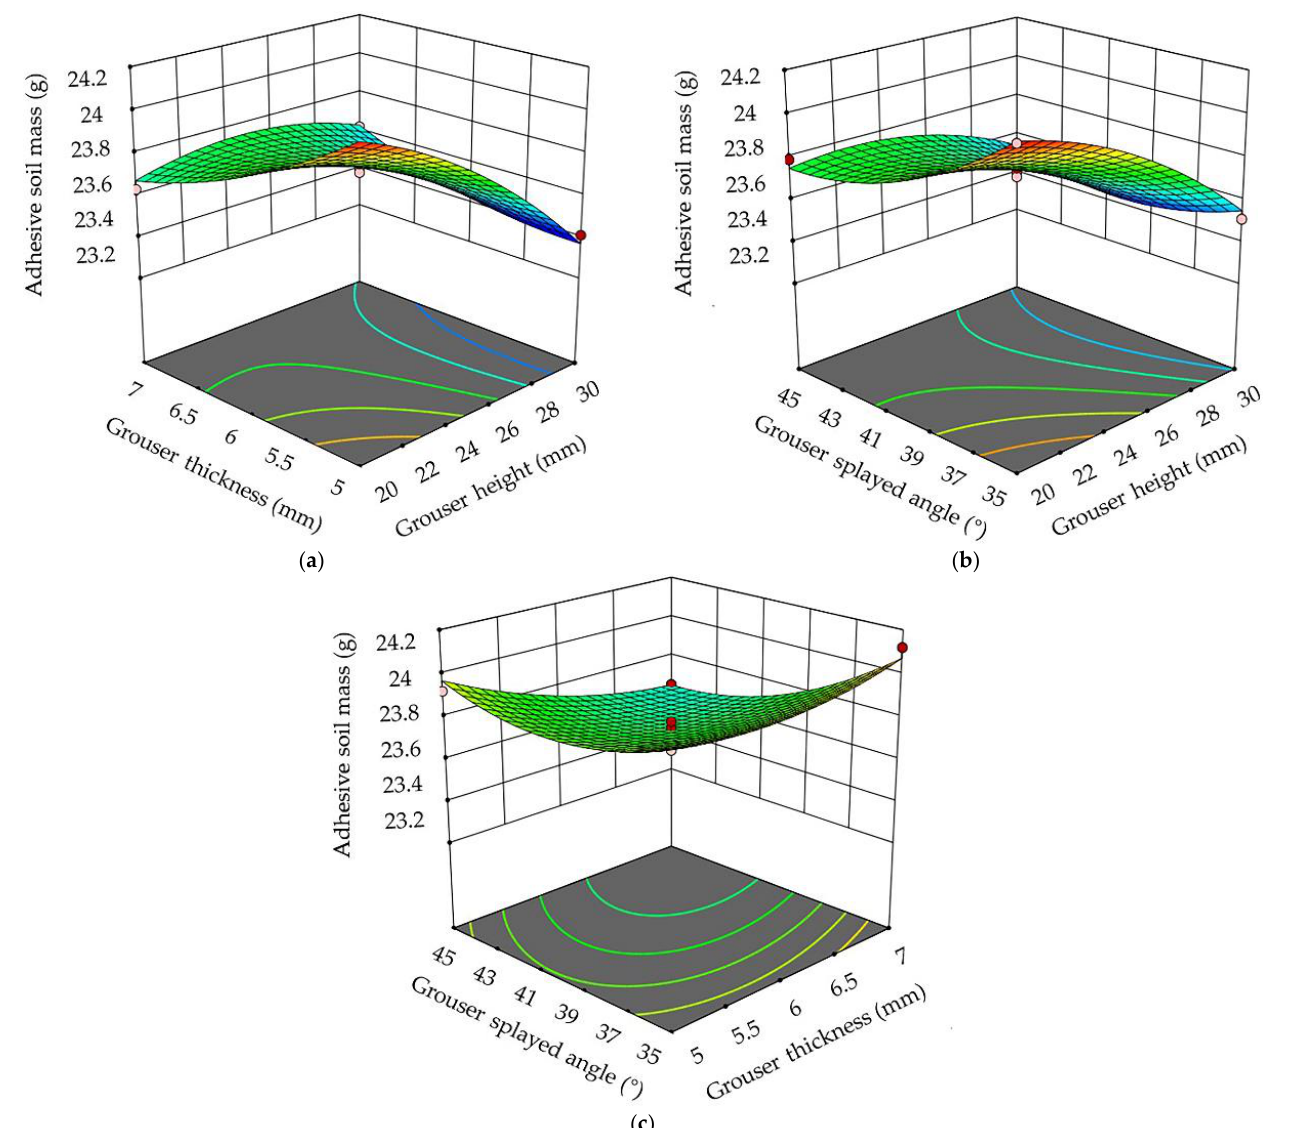
Figure 5. 3D response surface diagram of pairwise interaction of the grouser height, grouser thickness, and grouser splayed angle on adhesive soil mass. ( a ) Interaction of grouse height and grouser thickness; ( b ) interaction of grouser height and grouser splayed angle; ( c ) interaction of grouser thickness and grouser splayed angle.